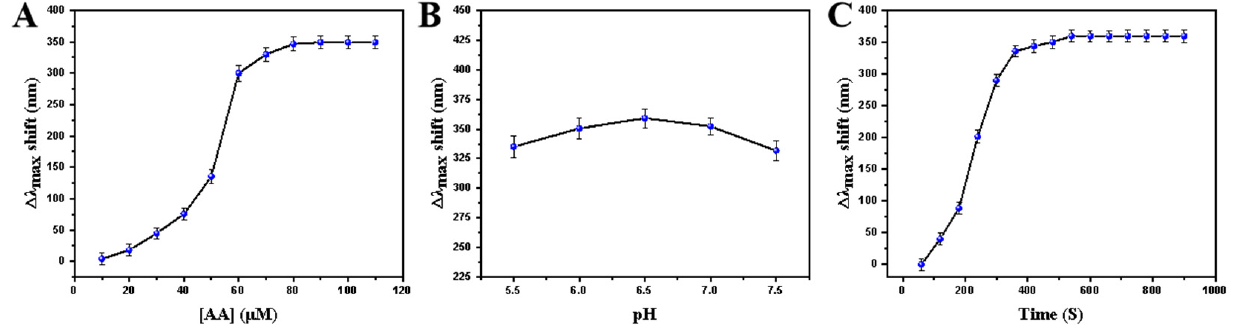
Figure 3. Optimization of experimental conditions on Hg 2+ sensing. ( A ) The ∆ λ max shift statistics of concave cube Au nanoparticles under different AA concentrations. ( B ) The ∆ λ max shift statistics of concave cube Au nanoparticles under different pH. ( C ) The ∆ λ max shift statistics of concave cube Au nanoparticles with different reaction times.